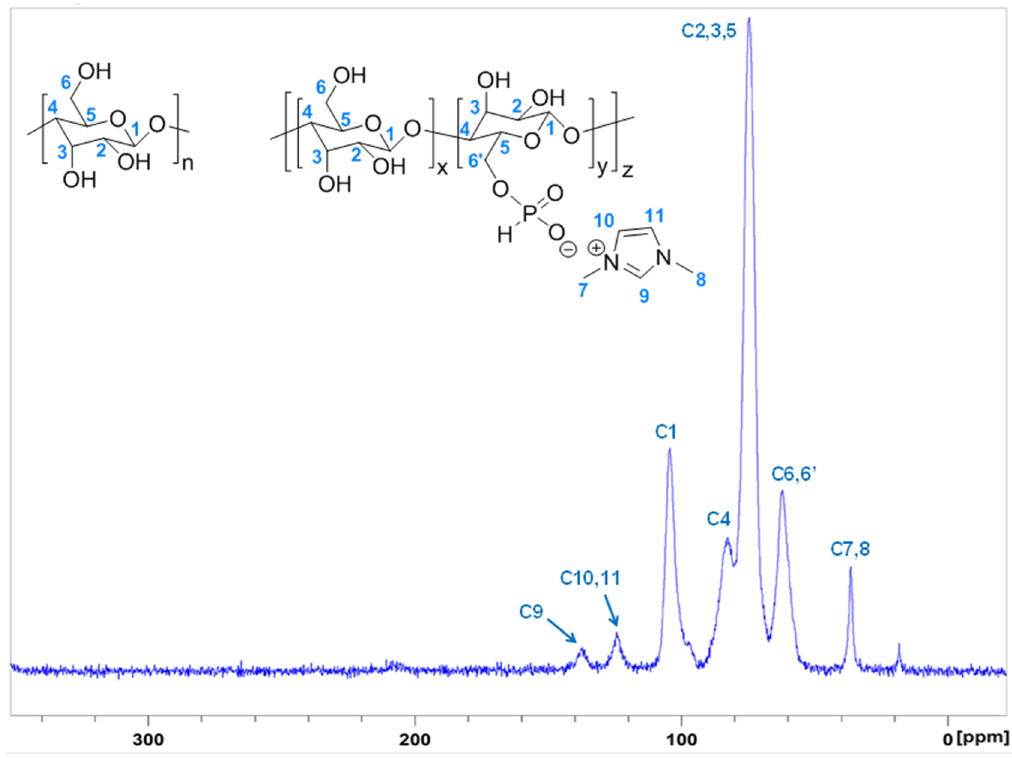
Figure 4. ¹³C NMR spectrum of regenerated cellulose dissolved in [DIMIM][(MeO)(H)PO 2 ] (mass fraction of cotton fiber in [DIMIM][(MeO)(H)PO 2 ]; 5 wt%).